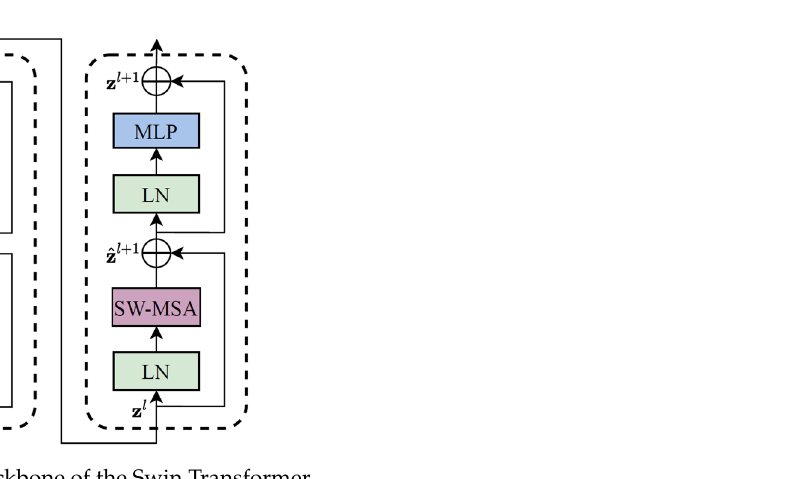
5 of 17 Table 1. Details of the data sets. Dataset